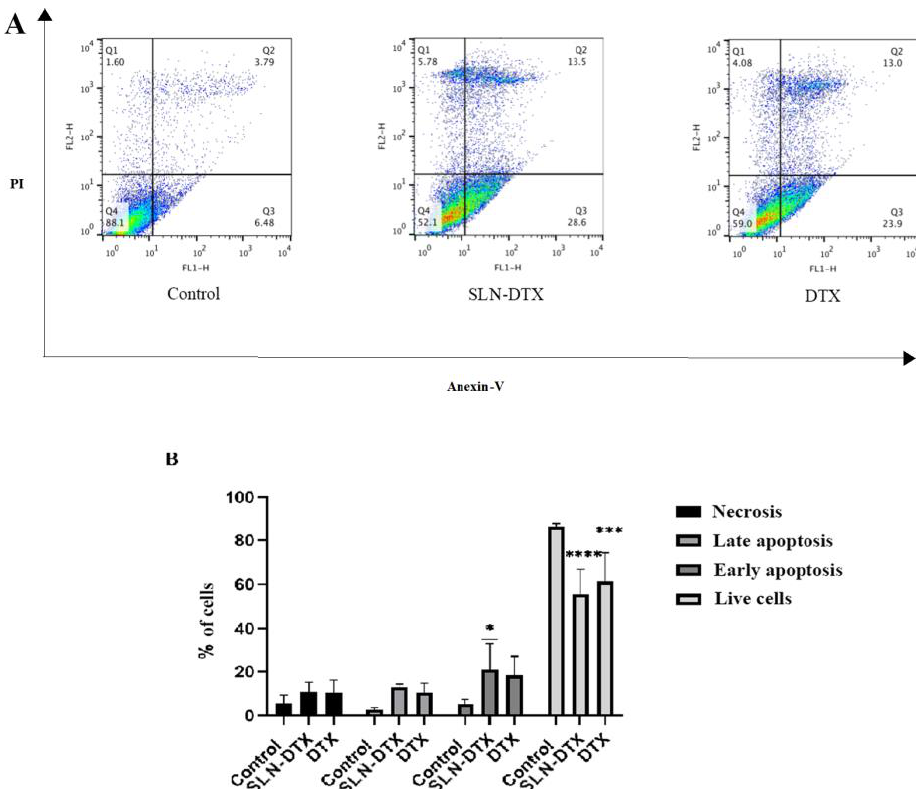
Figure 11. Analysis of cell death type. ( A ) Cell distribution according to the markings profile. Q1: necrotic cells, Q2: late apoptosis, Q3: early apoptosis, Q4: viable cells. The colors represent